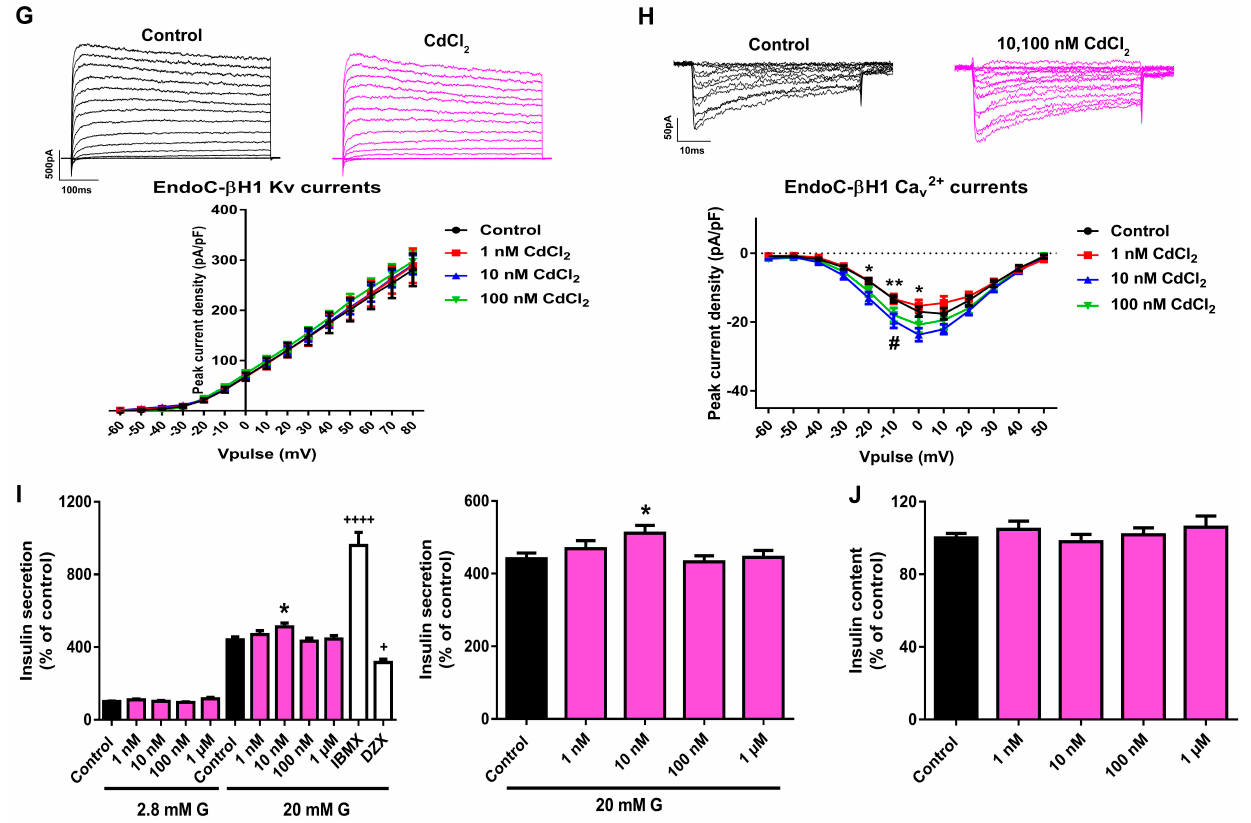
Figure 5. CdCl 2 effects on pancreatic β -cells. ( A ) Viability of MIN6 cells treated for 24 h with different CdCl 2 concentrations (100 pM–10 µ M) as evaluated by RZ, NRU and CFDA-AM assays. n = four independent experiments. * vs. Control; one-way ANOVA or Kruskal-Wallis. ( B ) mRNA expression of Ins , Pdx1 , Hnf4 α , MafA , Kir6.2 , Sur1 , Glut2 , and Gck in MIN6 cells treated for 24 h